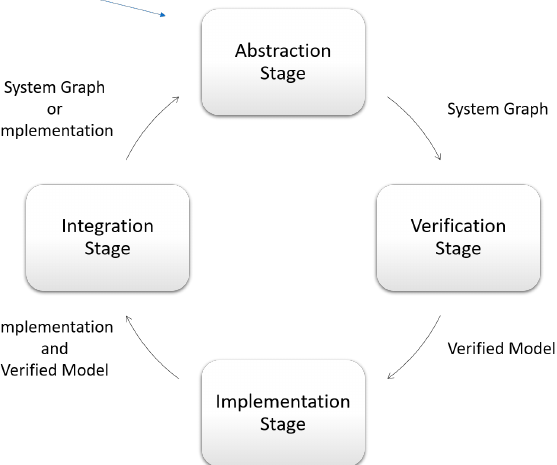
Figure 1. Stage transition graph of an